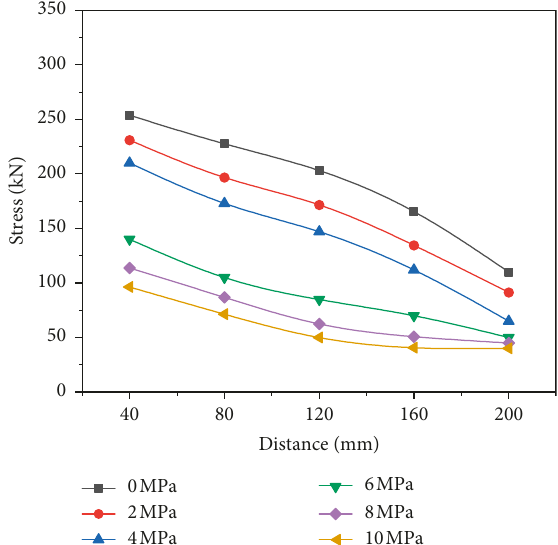
Figure 8: Physical attenuation law of stress waves in intact rock under different confining pressures.